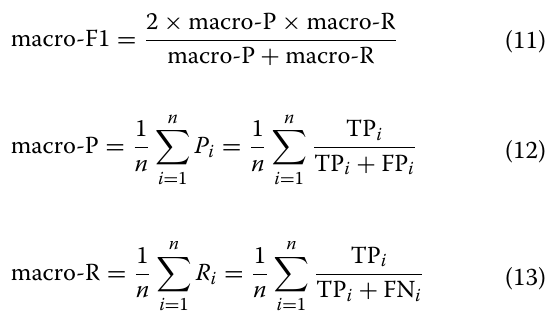
Table 1 The classification results of RT‑ERM with different time scales for θ rhythm under the dimension of emotion valence Time Assessment method (mean scale (s)